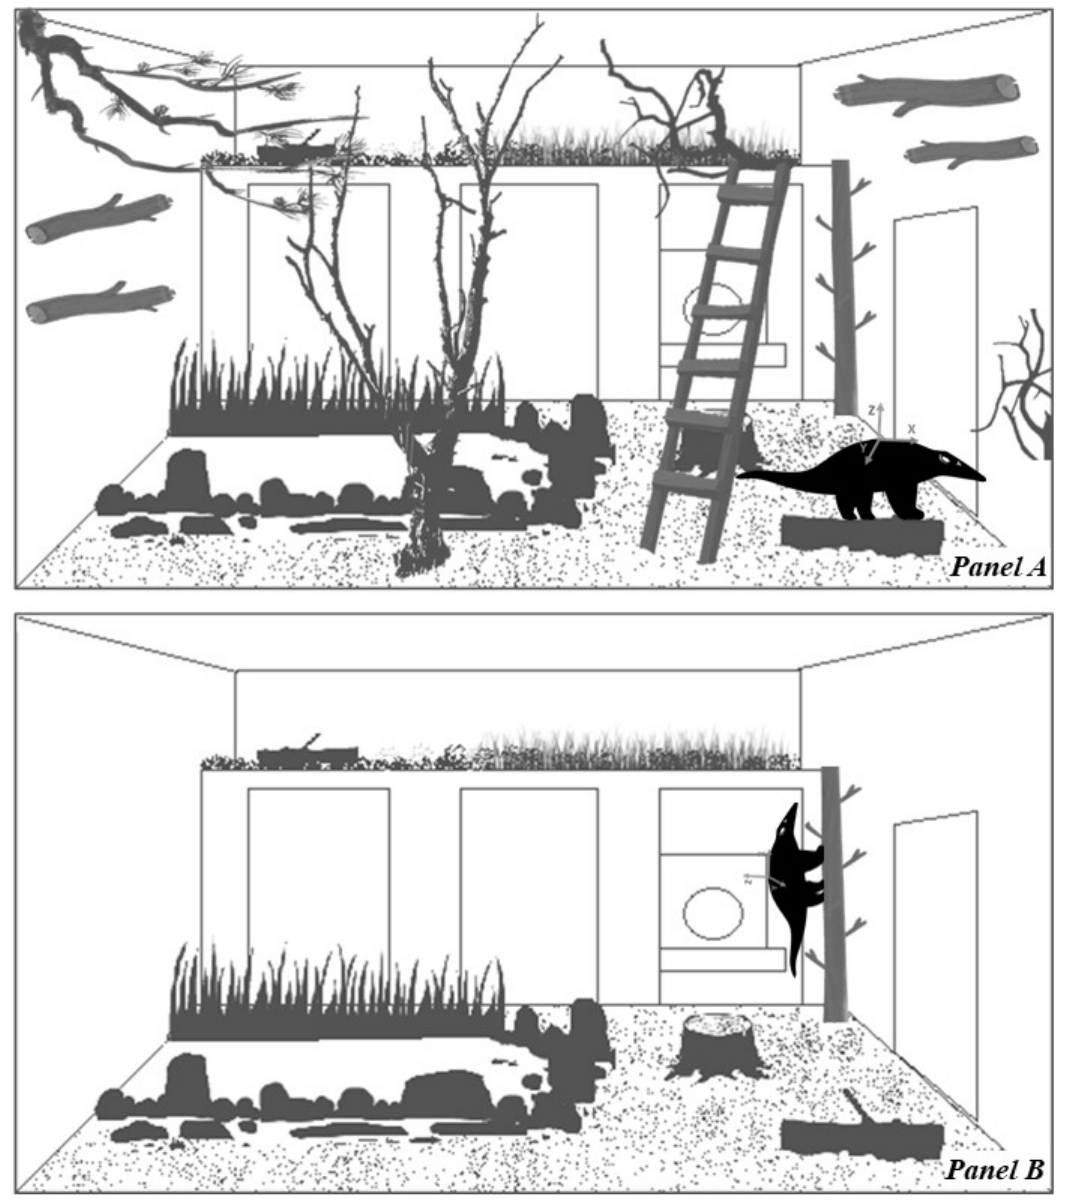
Figure 3. Diagram representing the enclosures used during Study 3 to evaluate behavioural re- sponse of adult lesser anteaters ( Tamandua tetradactyla ) to enclosure complexity. An ABA-type experimental design was carried out. Panel A: complex enclosure with climbing structures (stages A1 and A2). Panel B: enclosure with reduced complexity (stage B).